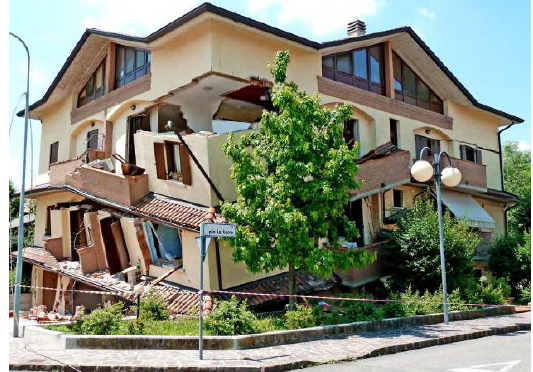
Figure 14. Liquefaction settlement-induced collapse of masonry